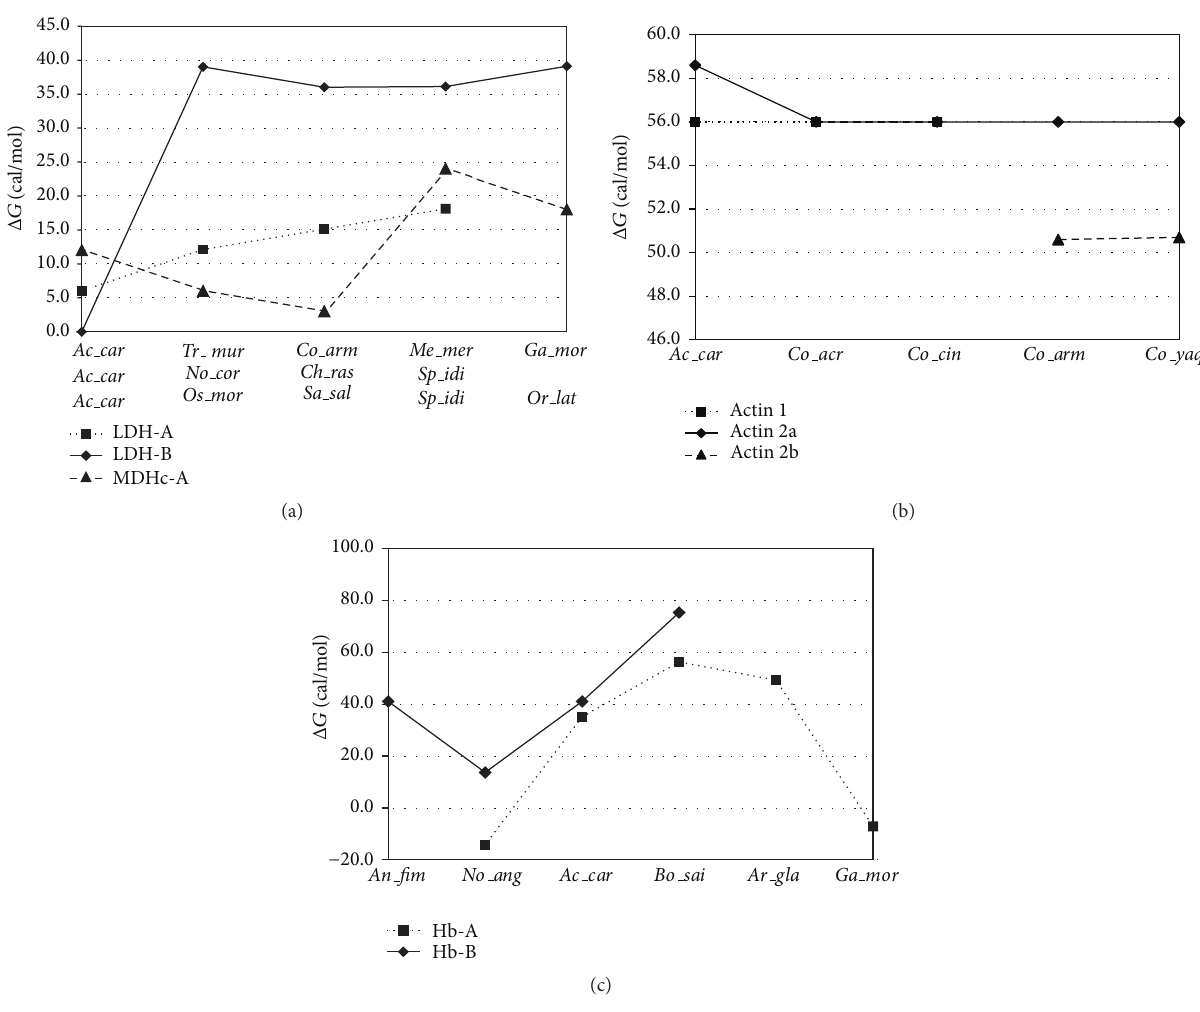
Figure 5: Comparative plots of normalised difference in protein stability ( Δ𝐺 ) for different functional genes among several representative species. Taxon coding includes the first two letters for the genus followed by three letters for the species name (see Table